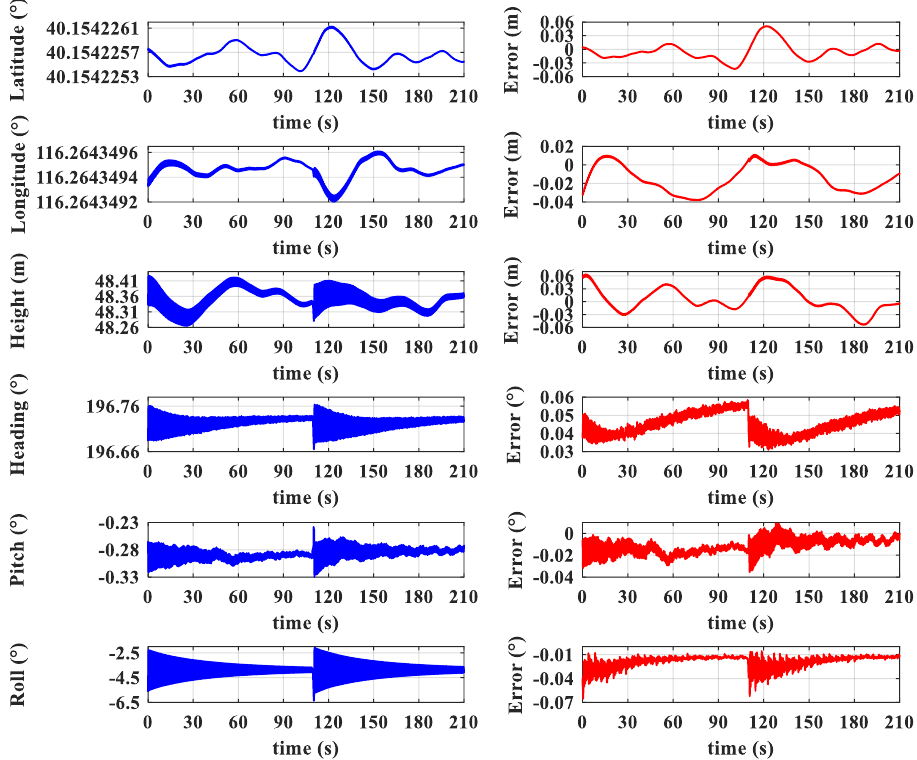
Figure 15. Measured values and errors of position and attitude for antenna 1.